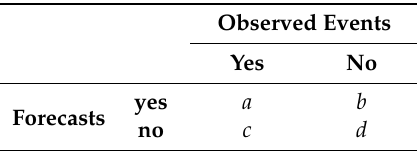
Table 3. Four-cell contingency table.